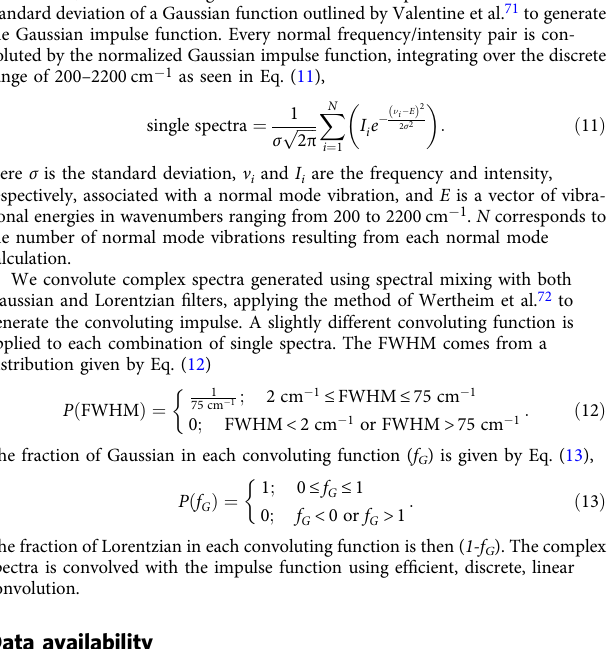
Section 10: Spectral convolution . To generate the Gaussian function for initial convolution, we take advantage of the linear relationship between FWHM and the standard deviation of a Gaussian function outlined by Valentine et al. 71 to generate the Gaussian impulse function. Every normal frequency/intensity pair is con- voluted by the normalized Gaussian impulse function, integrating over the discrete range of 200 – 2200 cm − 1 as seen in Eq.